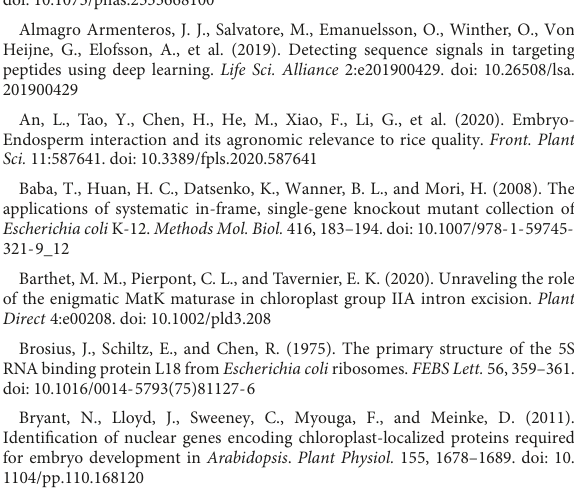
SUPPLEMENTARYFIGURE2 Identification of the T-DNA free ko-1 /+ mutant